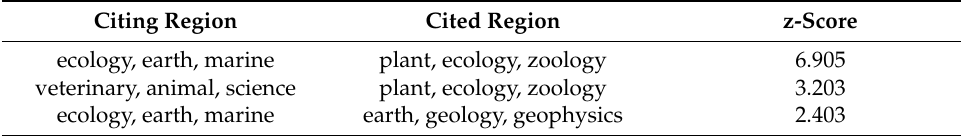
Table 6. Three key citation trends.